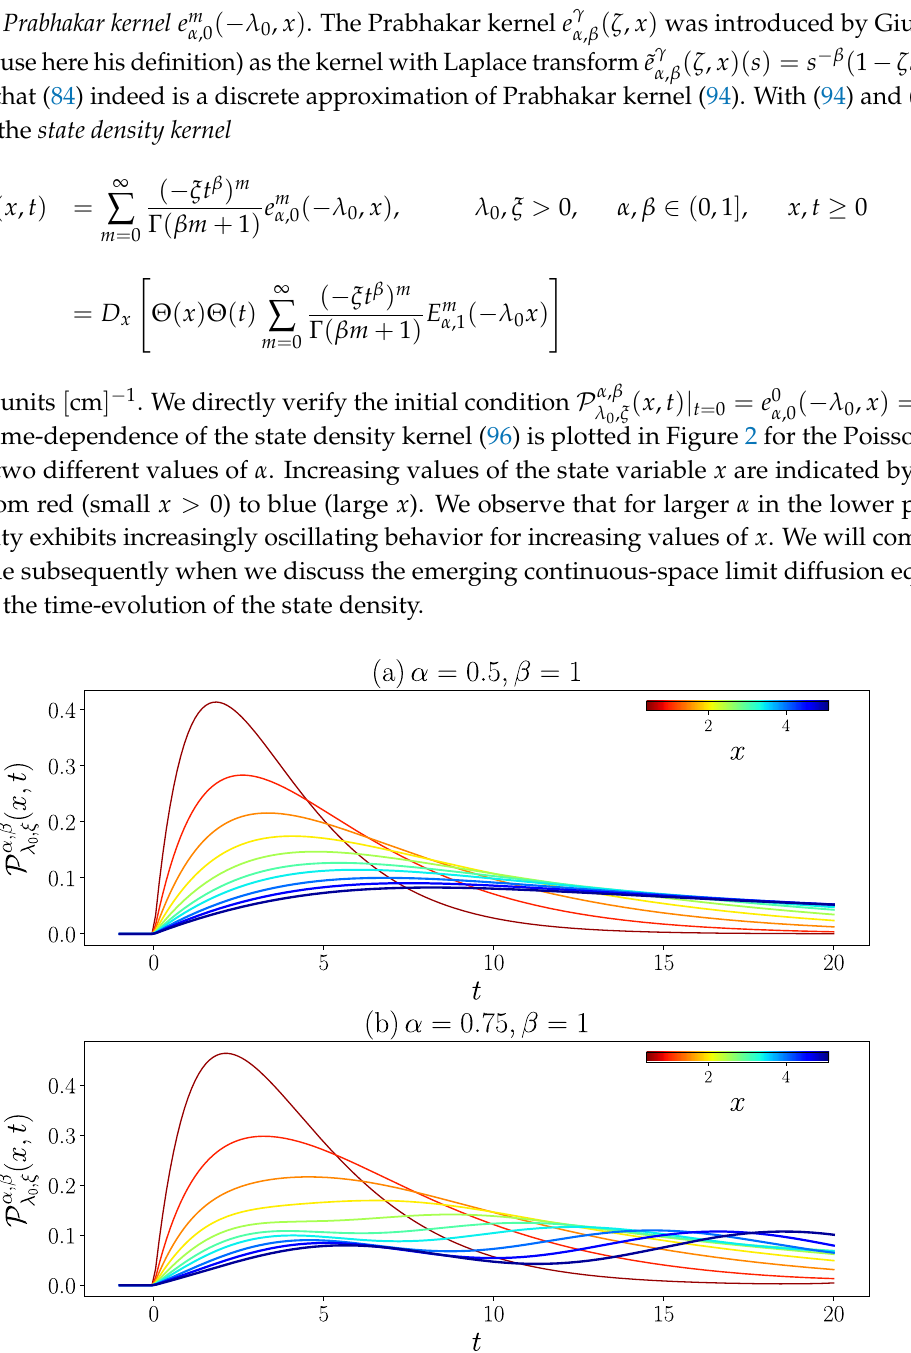
( x , t ) as a function of t . The results are obtained numerically Figure 2. State density kernel P α , β λ 0 , ξ from Equation (96) for: ( a ) α = 0.5 and ( b ) α = 0.75 maintaining constant λ 0 = 1, ξ = 1 and β =